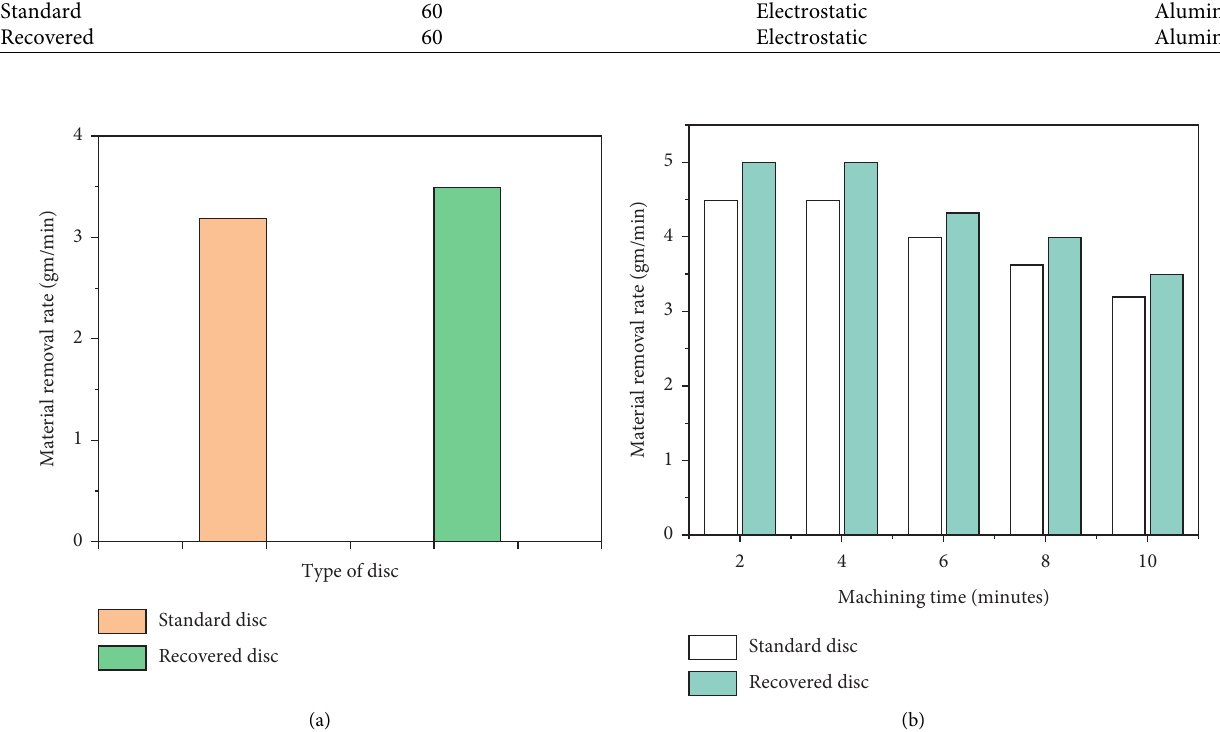
Figure 6: Material removal rate of performance results of coated abrasive